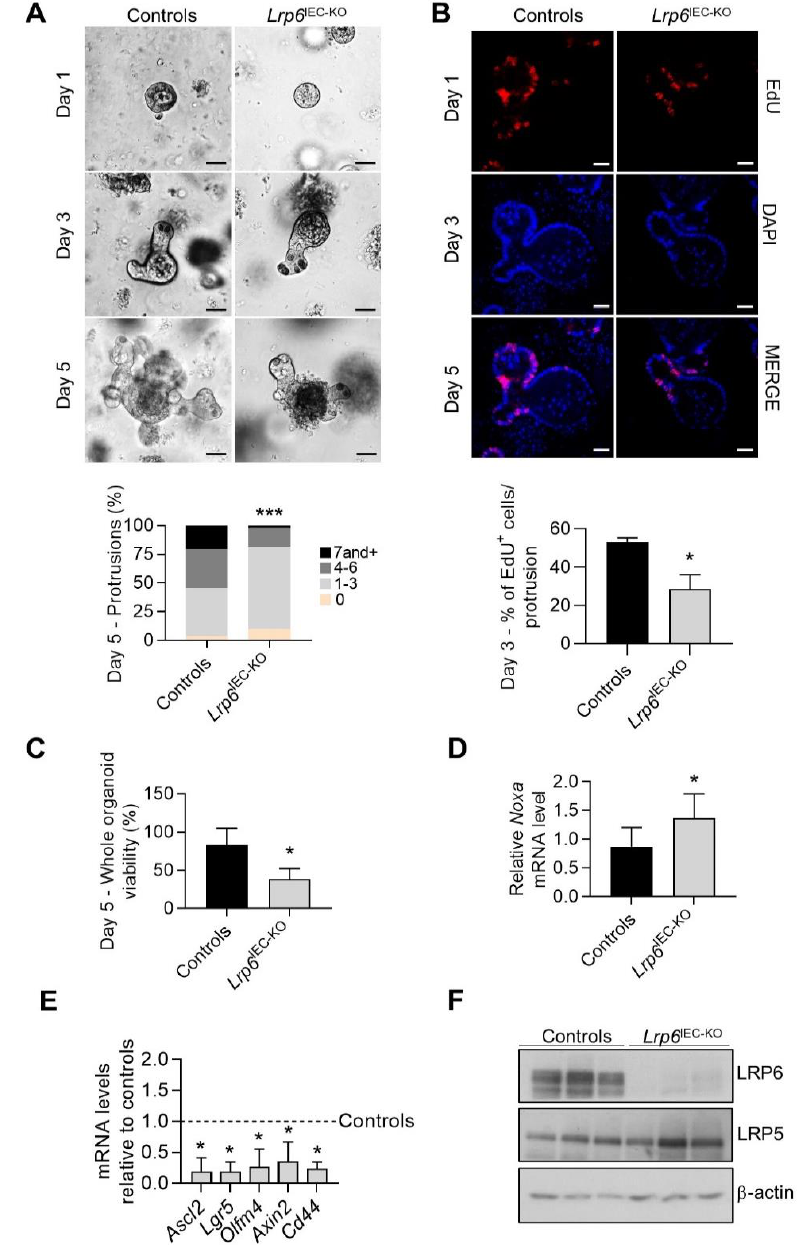
Figure 2. Loss of LRP6 expression impairs enteroid development. ( A ) Phase contrast images of enteroids 1, 3 and 5 days after seeding. Bars: 50 µm. Protrusions per enteroid were counted 5 days after seeding. The average of 6 independent